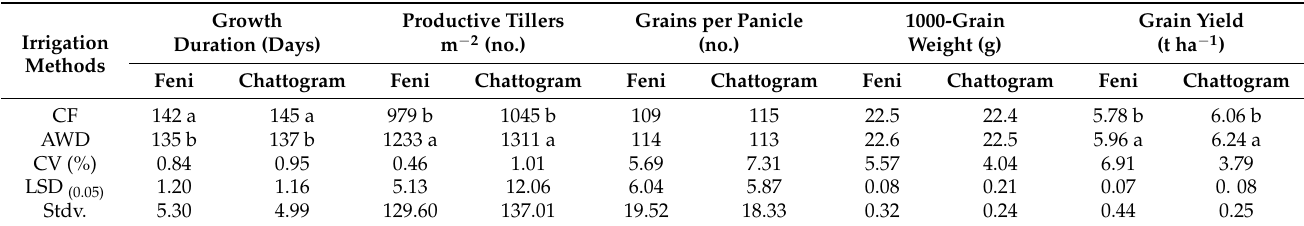
Table 3. Effect of irrigation methods on the yield attributes and yield of paddy at Feni and Chatto- gram districts.